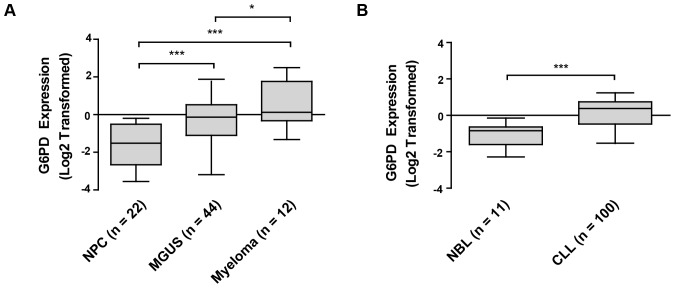
Increased G6PD expression is observed in MM and CLL patient samples.(A) G6PD expression was interrogated in clinical myeloma samples through querying the dataset ‘Zhan Myeloma 3’ for G6PD probe set ‘202275_at’ in the Oncomine™ database. MM samples exhibit a 4.745 fold increase in G6PD expression relative to normal plasma cells (NPC). MGUS: Monoclonal Gammopathy of Undetermined Significance. According to the authors Zhan et al [31], the diagnosis of MGUS included the following criteria: levels of monoclonal protein ≤30 g/L, plasma cell bone marrow infiltration <10%, and no incidence of related organ or tissue impairment. (B) G6PD expression was interrogated in clinical CLL samples through querying the dataset ‘Haslinger Leukemia’ for G6PD probe set ‘38043_at’ in the Oncomine™ database. CLL samples exhibit a 2.319 fold increase in G6PD expression relative to normal B lymphocytes (NBL). Data in parts (A) and (B) are log2 transformed and median-centered. Boxes indicate 95 and 5 percentiles and median expression values. Whiskers represent minimum and maximum expression values. * P<.05 ** P<.01 *** P<.005.